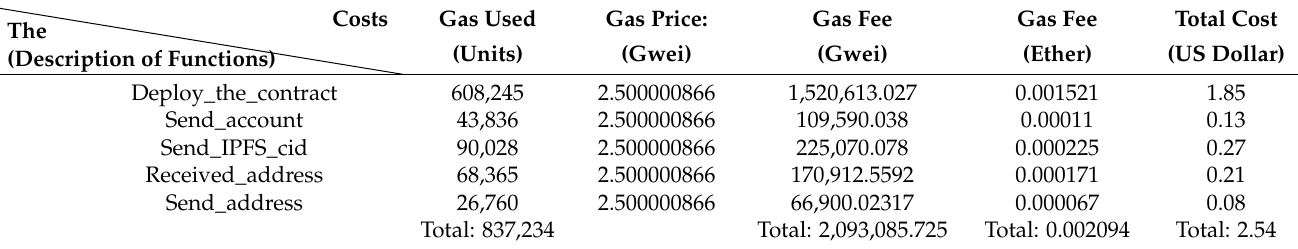
Table 6. The gas cost in executing functions in the proposed